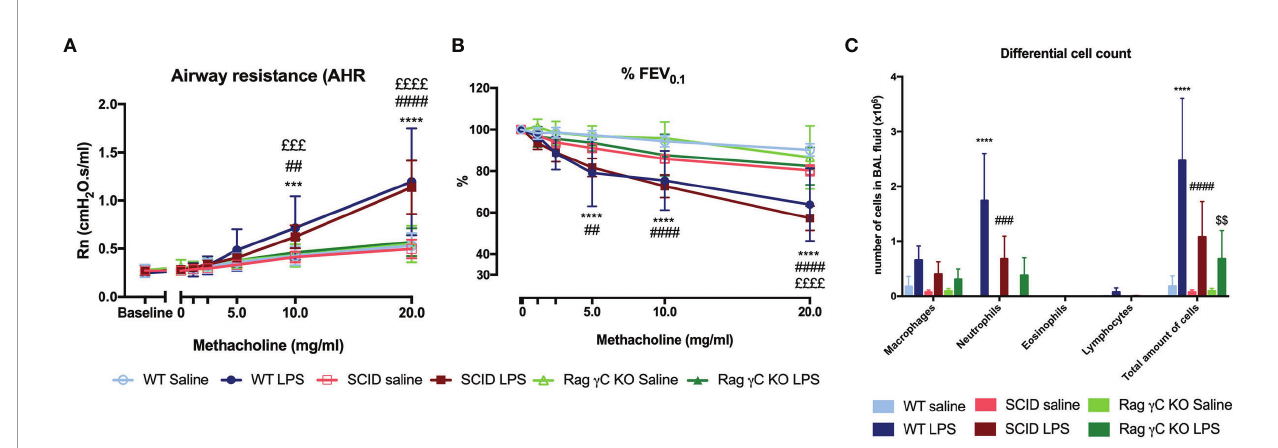
FIGURE 5 | Comparison of the LPS asthma model in different mouse strains. Wild-type BALB/c mice (WT), SCID mice, and Rag2 -/- g C -/- mice (on BALB/c background) were exposed to LPS (2 µg in 50 µl saline) via the nose on four consecutive days ( Supplementary Figure 1A ). On day 5, lung function parameters were measured using the FlexiVent and BAL fl uid was obtained to determine the differential cell count. Airway resistance [Rn, (A) ] and FEV 0.1 [%, (B) ] before and after methacholine provocation (0 – 20 mg/ml) were measured in saline-treated WT mice (n = 8), LPS-treated WT mice (n = 9), saline-treated SCID mice (n = 10), LPS- treated SCID mice (n = 10), saline-treated Rag2 -/- g C -/- mice (n = 10), and LPS-treated Rag2 -/- g C -/- mice (n = 10). Data are represented as mean with standard deviation. Differential cell count (C) was identi fi ed in BAL fl uid of the same mice and represented as mean with standard deviation. ***p < 0.001; ****p < 0.0001 (WT saline versus WT LPS). ## p < 0.01; ### p < 0.001; #### p < 0.0001 (SCID saline versus SCID LPS). £££ p < 0.001; ££££ p < 0.0001 (WT LPS versus Rag2 -/- g C -/- LPS). $$ p < 0.01 (Rag2 -/- g C -/- saline versus Rag2 -/- g C -/- LPS).